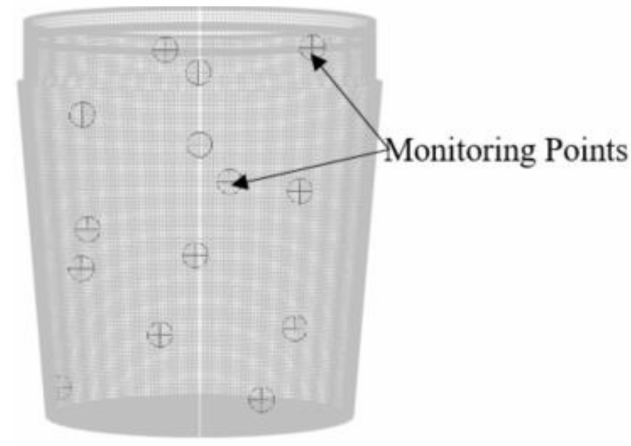
Figure 2. Steel zone showing marked regions.